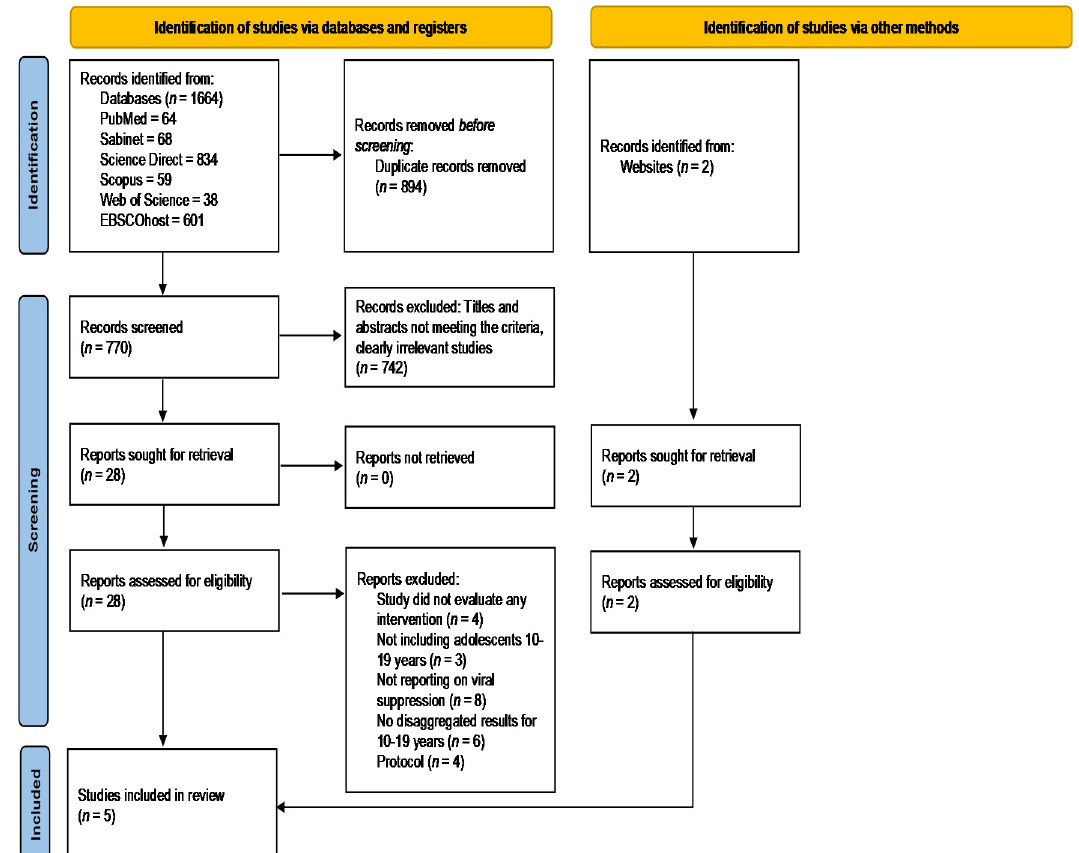
Figure 1. PRISMA 2020 flow diagram.